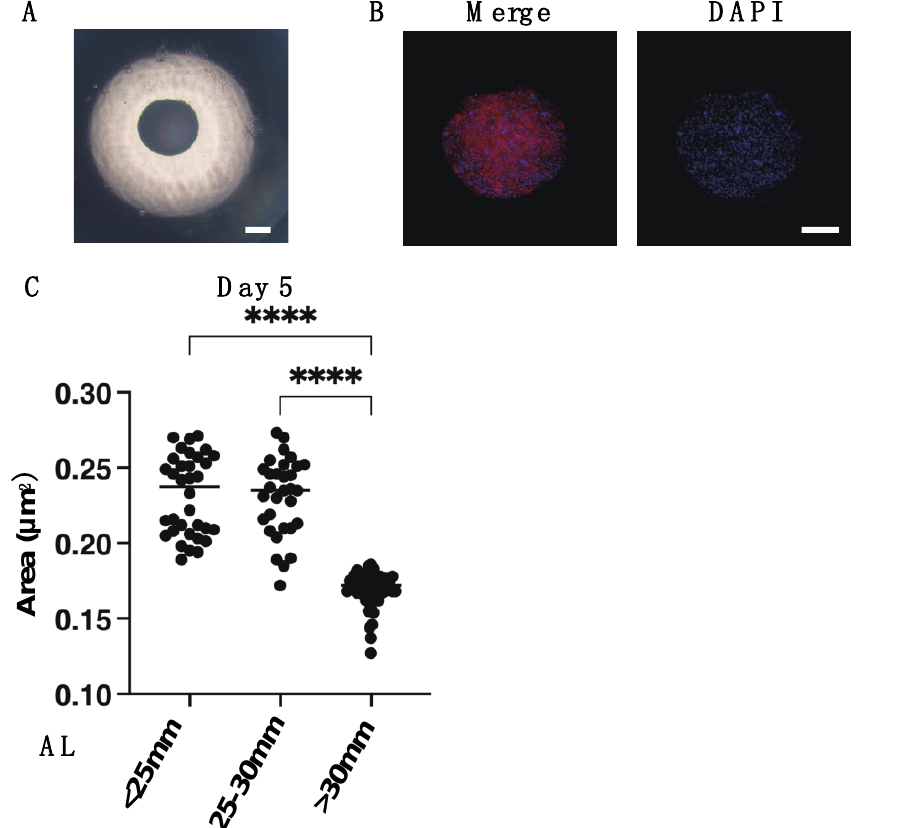
Figure 1. Representative images by phase contrast microscopy ( A ) and immunohistochemistry ( B ), and the mean sizes of the 3D spheroids of human scleral stroma fibroblasts (HSSFs) with various axial lengths (ALs) ( C ). Representative images by phase contrast (PC, panel A) and immunolabeling with DAPI and phalloidin (scale bar: 100 µm) (panel B) of 3D HSSFs spheroids at Day 5 are shown. Among three different ALs, <25 mm, 25–30 mm, or >30 mm, the mean sizes of the 3D HSSFs spheroids are plotted in panel C. All experiments were performed in duplicate using fresh preparations ( n = 15 or 5 for size measurement or PC and immunolabeling images, respectively, in each experimental group). Data are presented as the arithmetic mean ± standard error of the mean (SEM). **** p < 0.001 (ANOVA followed by Tukey’s multiple comparison test were examined).